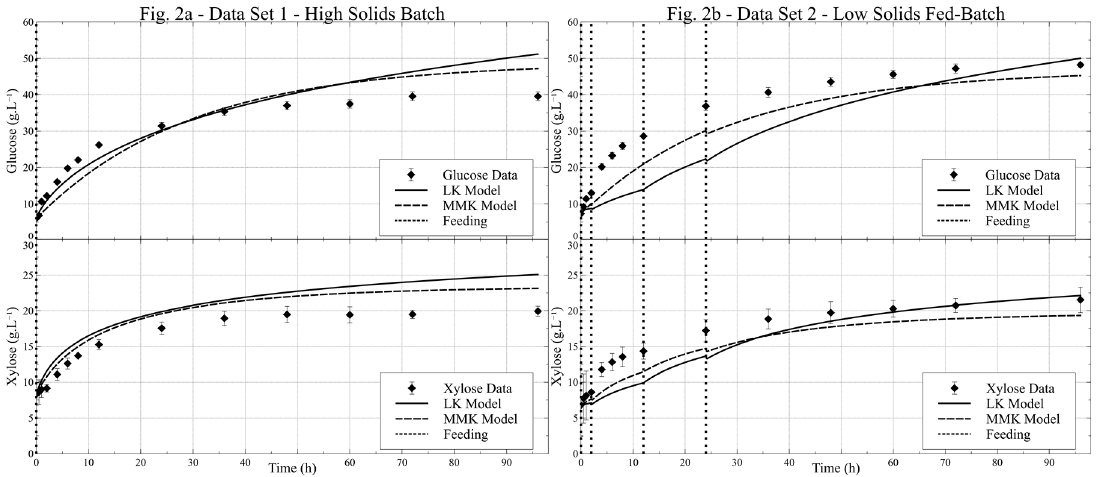
Figure 2. Michaelis-Menten kinetics (MMK) and Langmuir-Type kinetics (LK) models fitting—( a ) Models prediction for Data Set 1; ( b ) Models prediction for Data Set 2; error bars in data points are the standard errors between experiment’s duplicates for the compound concentration; vertical dotted lines are the solids feeding times.